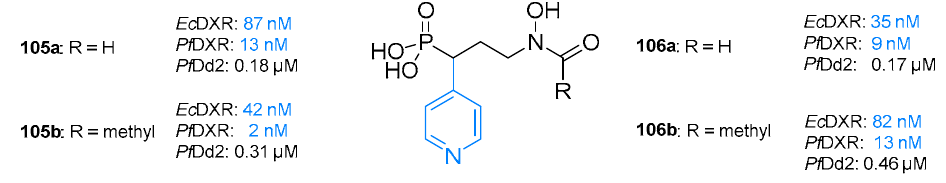
Figure 22. Rational design of α -pyridinyl DXR-inhibitors 105a, b and 106a, b . K i values are given in µ M (black) or nM (blue) against Ec DXR, Pf DXR and Pf Dd2. To elucidate the interactions between 106b and Pf DXR, the crystal structure in complex with NADPH and Mn 2+ was solved and analyzed (Figure 23). In the crystal structure, the backbone of 106b showed similar interactions to previously analyzed DXR inhibitors with α -phenyl substituents (e.g., 66 , Figure 17) [32,94,140,141]. In addition, the